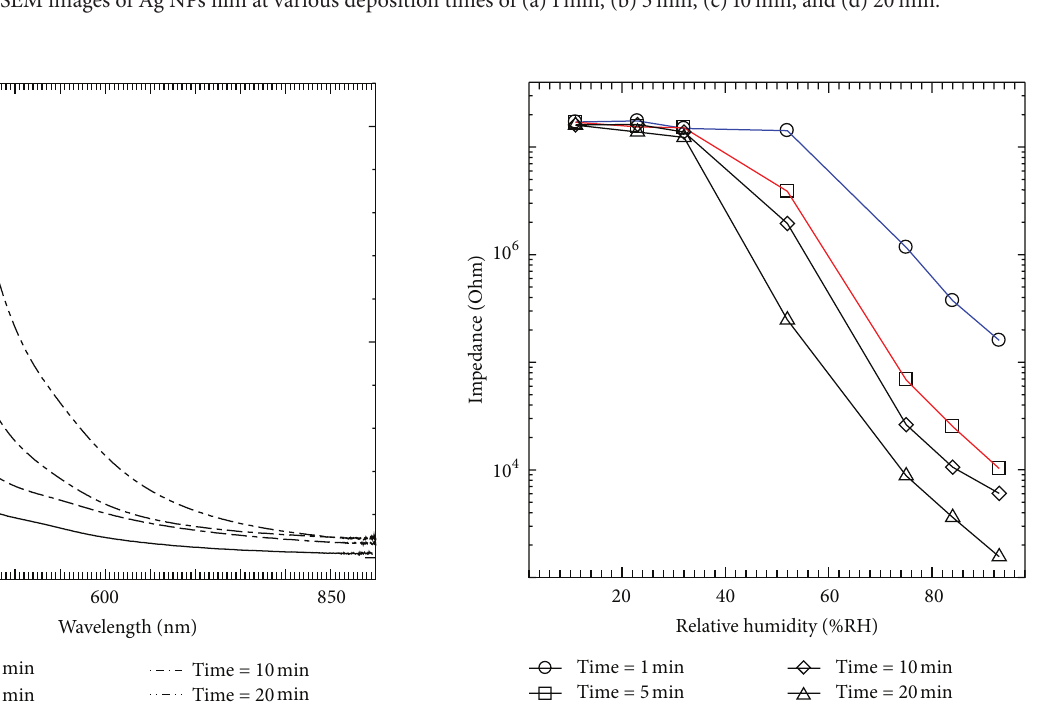
Figure 5: The relationships between the impedance of Ag NPs humidity sensor and the relative